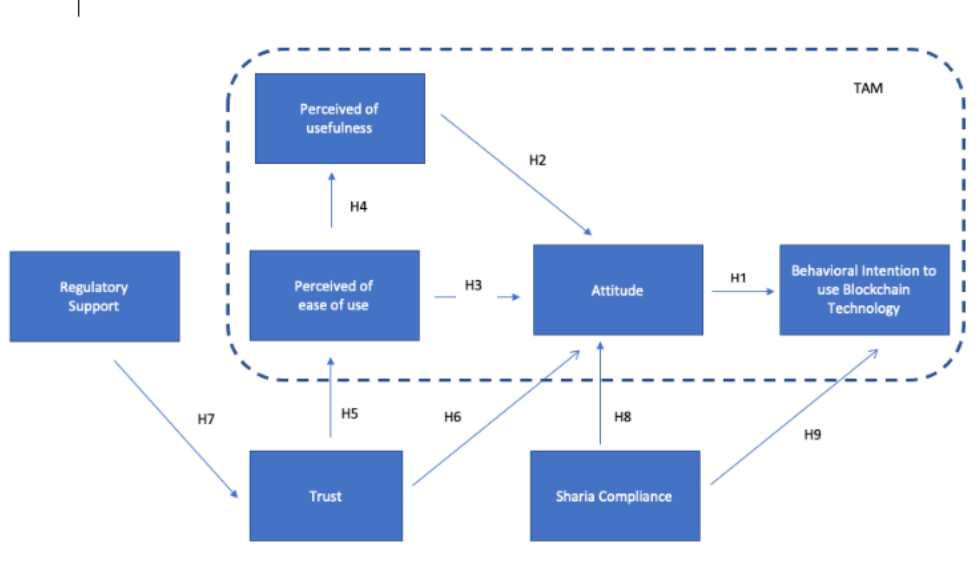
Figure 2. Proposed research